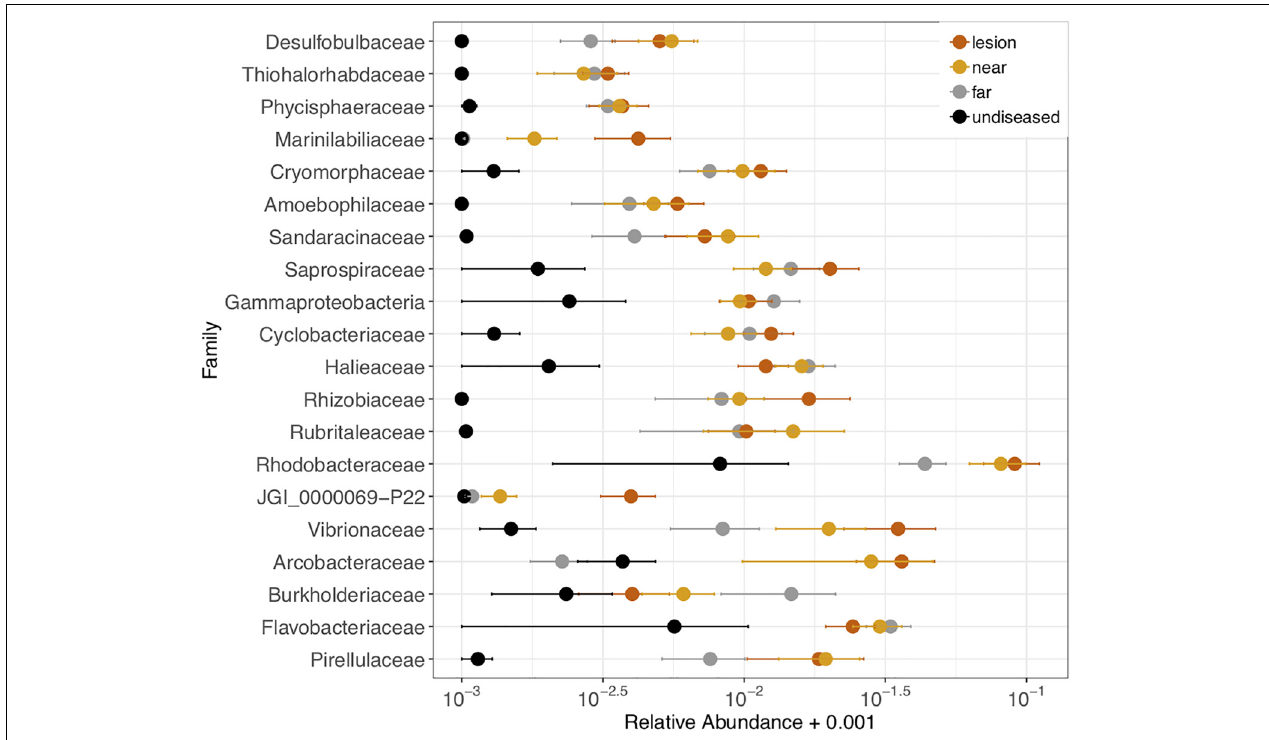
FIGURE 6 | Relative abundance of 21 microbial families that were differentially abundant across coral tissue types: disease lesions, apparently healthy tissue near the lesions, apparently healthy tissue far from the lesions on diseased colonies, and neighboring undiseased colonies. Points represent the average relative abundance and error bars depict the standard error from analysis of all 62 coral samples. For display on a logarithmic scale, 0.001 was added to all values to avoid taking the log of